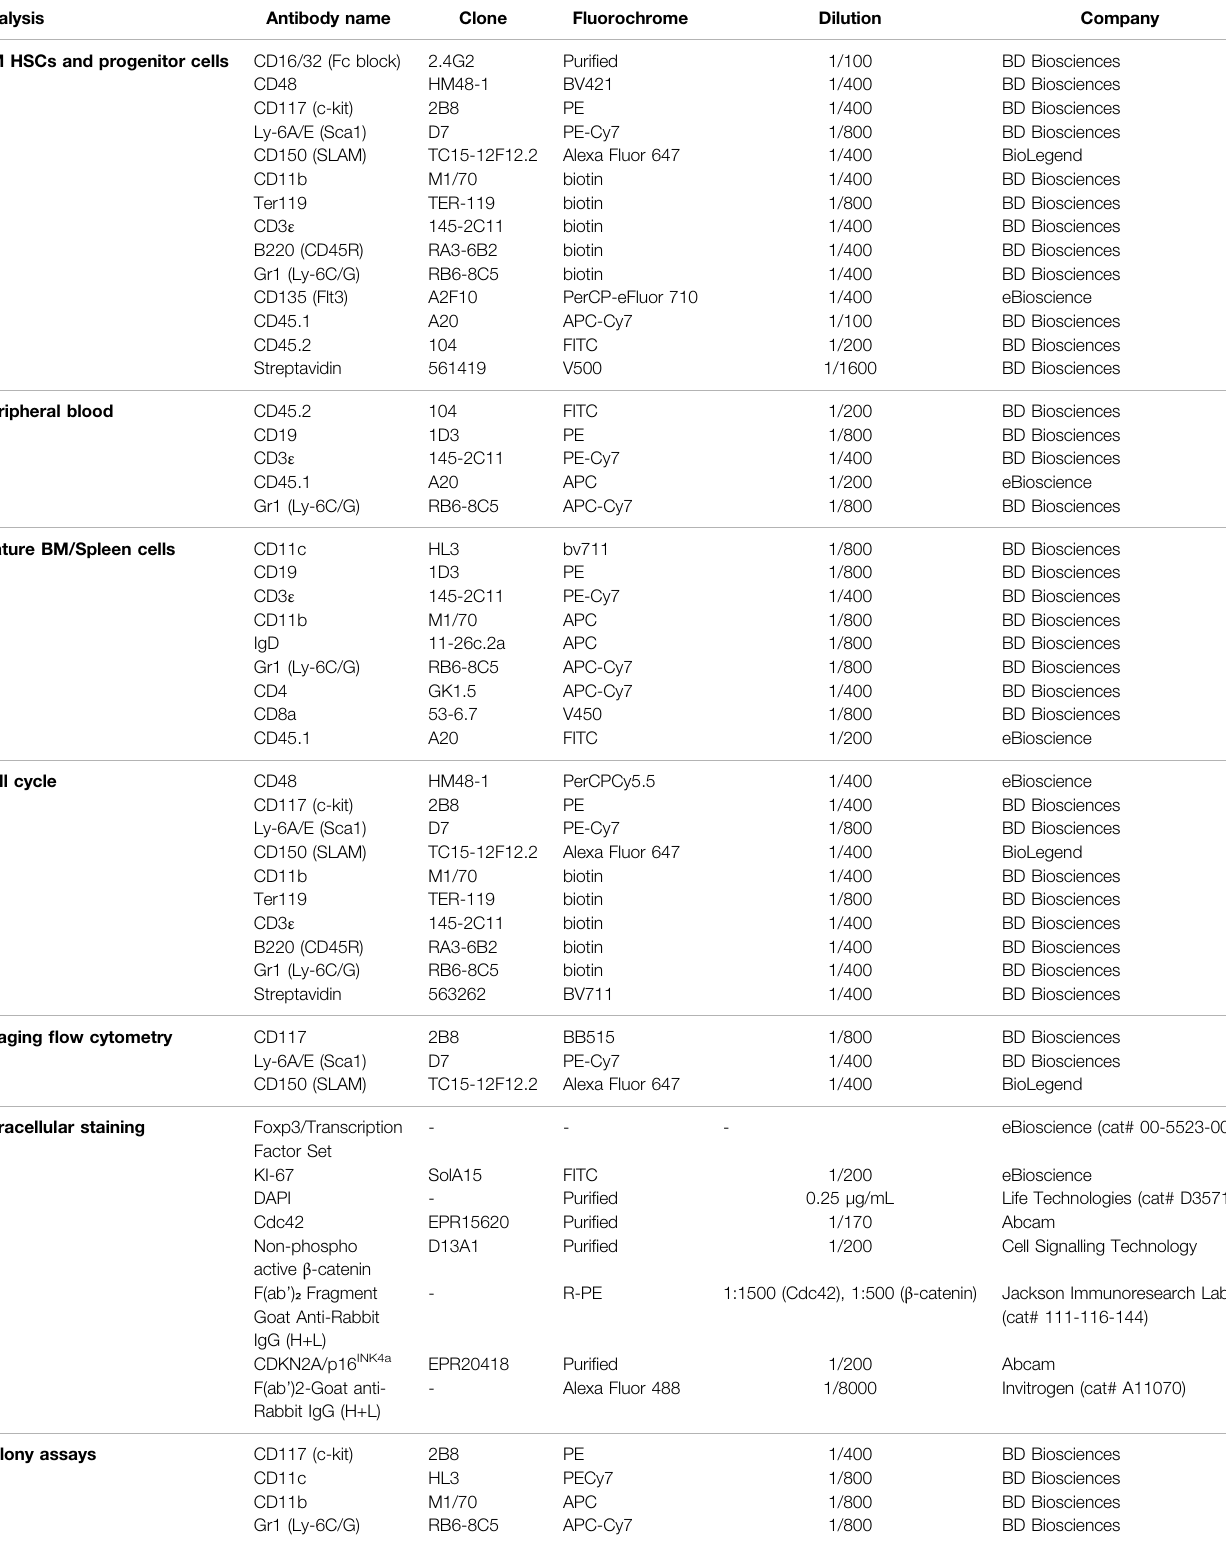
TABLE 1 | List of antibodies used for fl ow